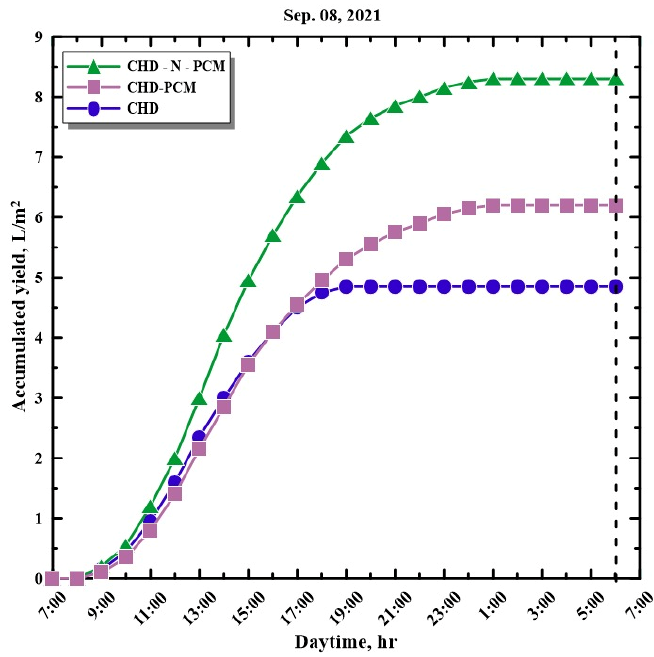
Figure 9. Hourly variation in accumulated yield with time. Table 5. Cumulative distillation output of CHD, CHD-PCM, and CHD-N-PCM during trial hours. Day Time Pro- Solar Still